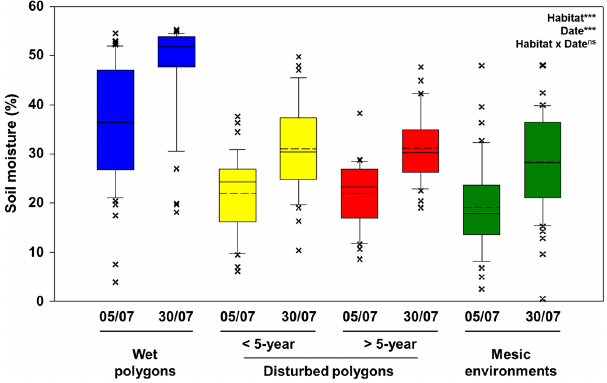
Figure 3. Soil moisture monitored early and late July 2010 in the four habitat types studied in the Qarlikturvik valley, Bylot Is- land, Nunavut. The 10th percentile, lower quartile, median (solid line), mean (dashed line), upper quartile and 90th percentile are shown. See Table A1 for sample sizes and post-hoc contrasts. ∗∗∗ P <0.001, ns: statistically non-significant